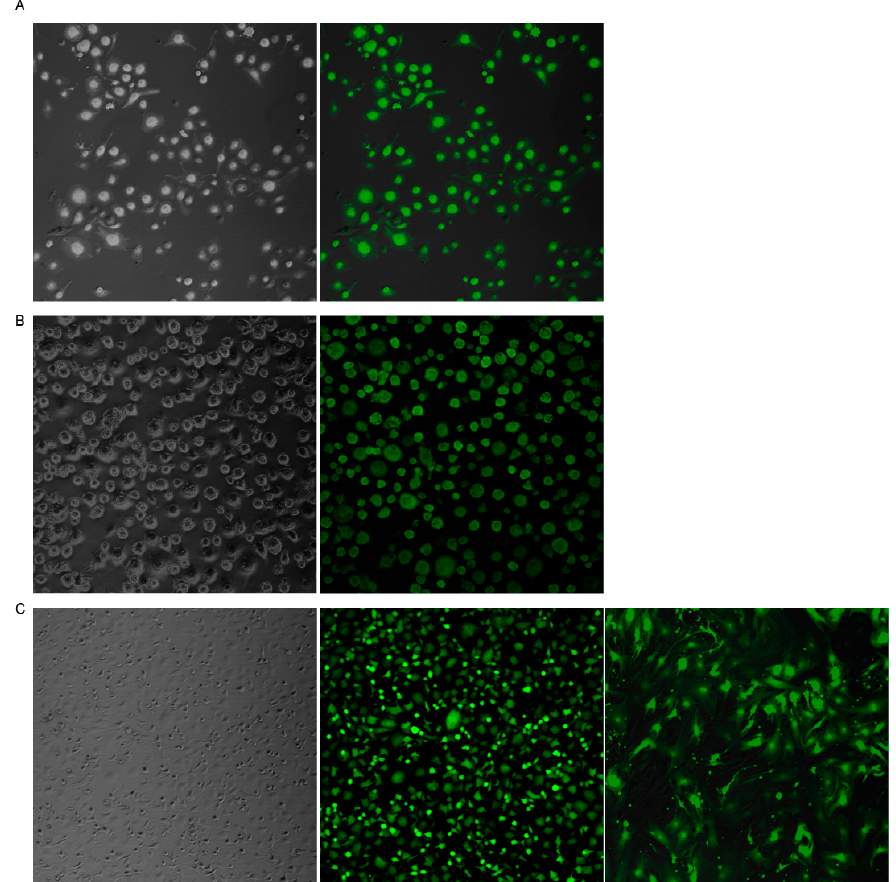
Figure 1. Sendai virus (SeV)-green fluorescent protein (GFP) infection of ovine cells. Fluorescence microscopy images of alveolar macrophages (AMs) ( A ), blood derived macrophages (BDMs) ( B ), and ovine skin fibroblasts (OSFs) ( C ) infected with Sendai virus vector expressing the GFP (right panel) at a multiplicity of infection (MOI) of 10. Bright field images are shown in the left panel. The three cell types and all cells in the three cultures are GFP-positive. Ovine fibroblasts remained GFP-positive after 13 in vitro culture passages ( C , third image).